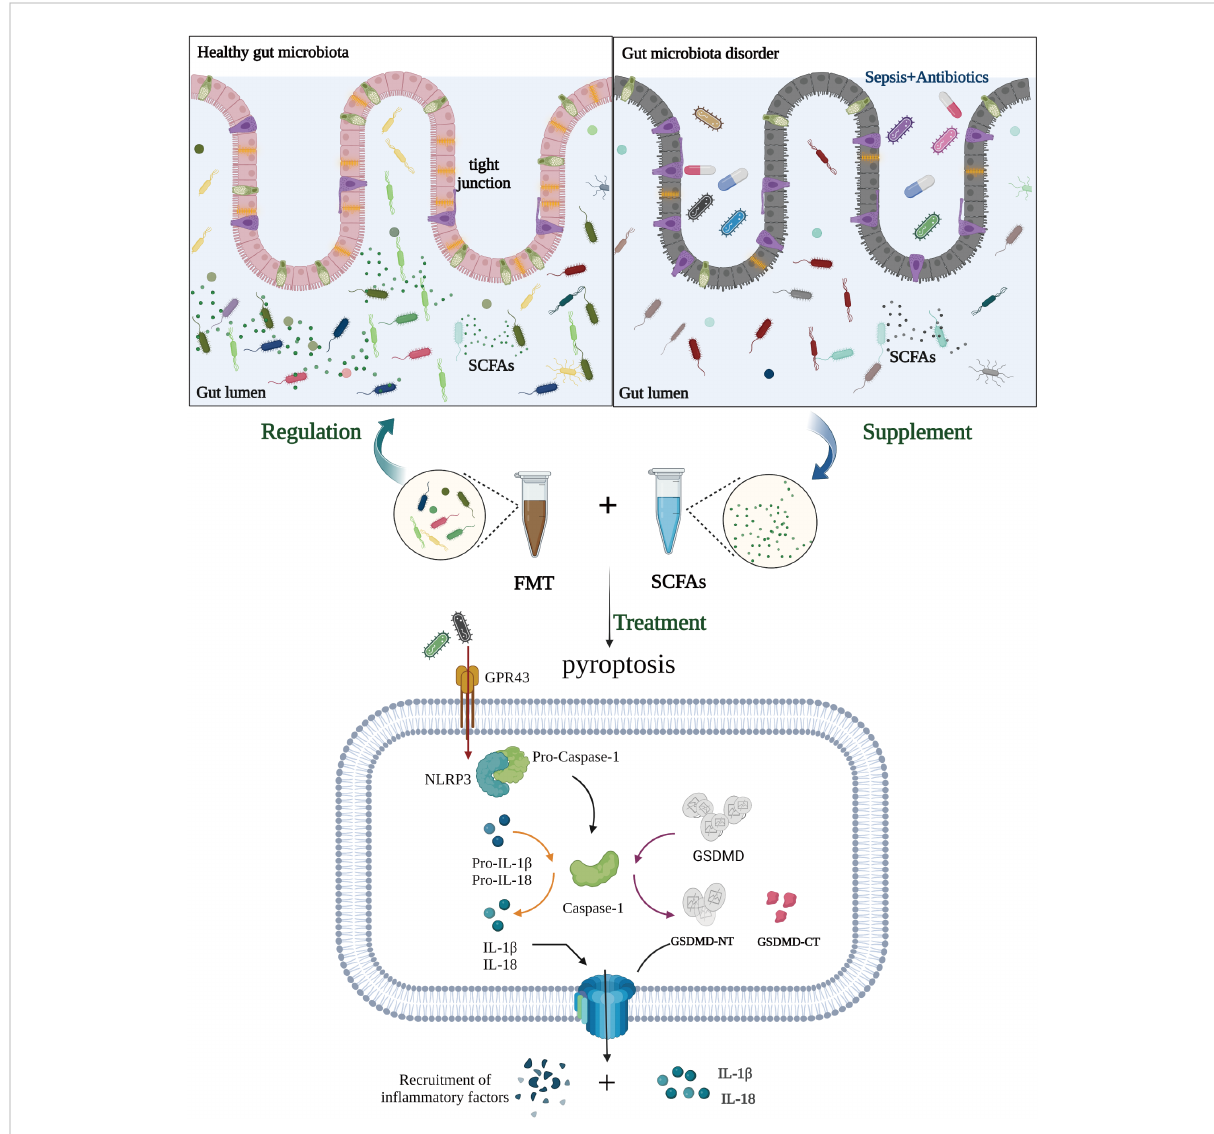
FIGURE 9 Potential role of fecal microbiota transplantation (FMT) and short-chain fatty acids (SCFAs) in treating sepsis. In the pathogenesis of sepsis, there is an imbalance in the intestinal fl ora, which decreases the production of SCFAs from intestinal fl ora metabolites and decreases the ability of SCFAs to bind to GPR43. It also induces further NOD-like receptor protein-3 (NLRP3) in fl ammasomes to be made and more IL-1 b and IL-18 to be released, exacerbating the in fl ammatory response of tissues and cells. In addition, NLRP3 triggers the activation of caspase-1, which in turn cleaves the gasdermin D (GSDMD) protein and triggers cell pyroptosis, hence exacerbating sepsis and perpetuating the vicious cycle. FMT and SCFAs can protect intestinal function, regulate the distribution and amount of intestinal fl ora, restore dominant intestinal fl ora, boost the production of SCFAs, limit in fl ammatory response and cell pyroptosis, and subsequently protect against sepsis. (Created with